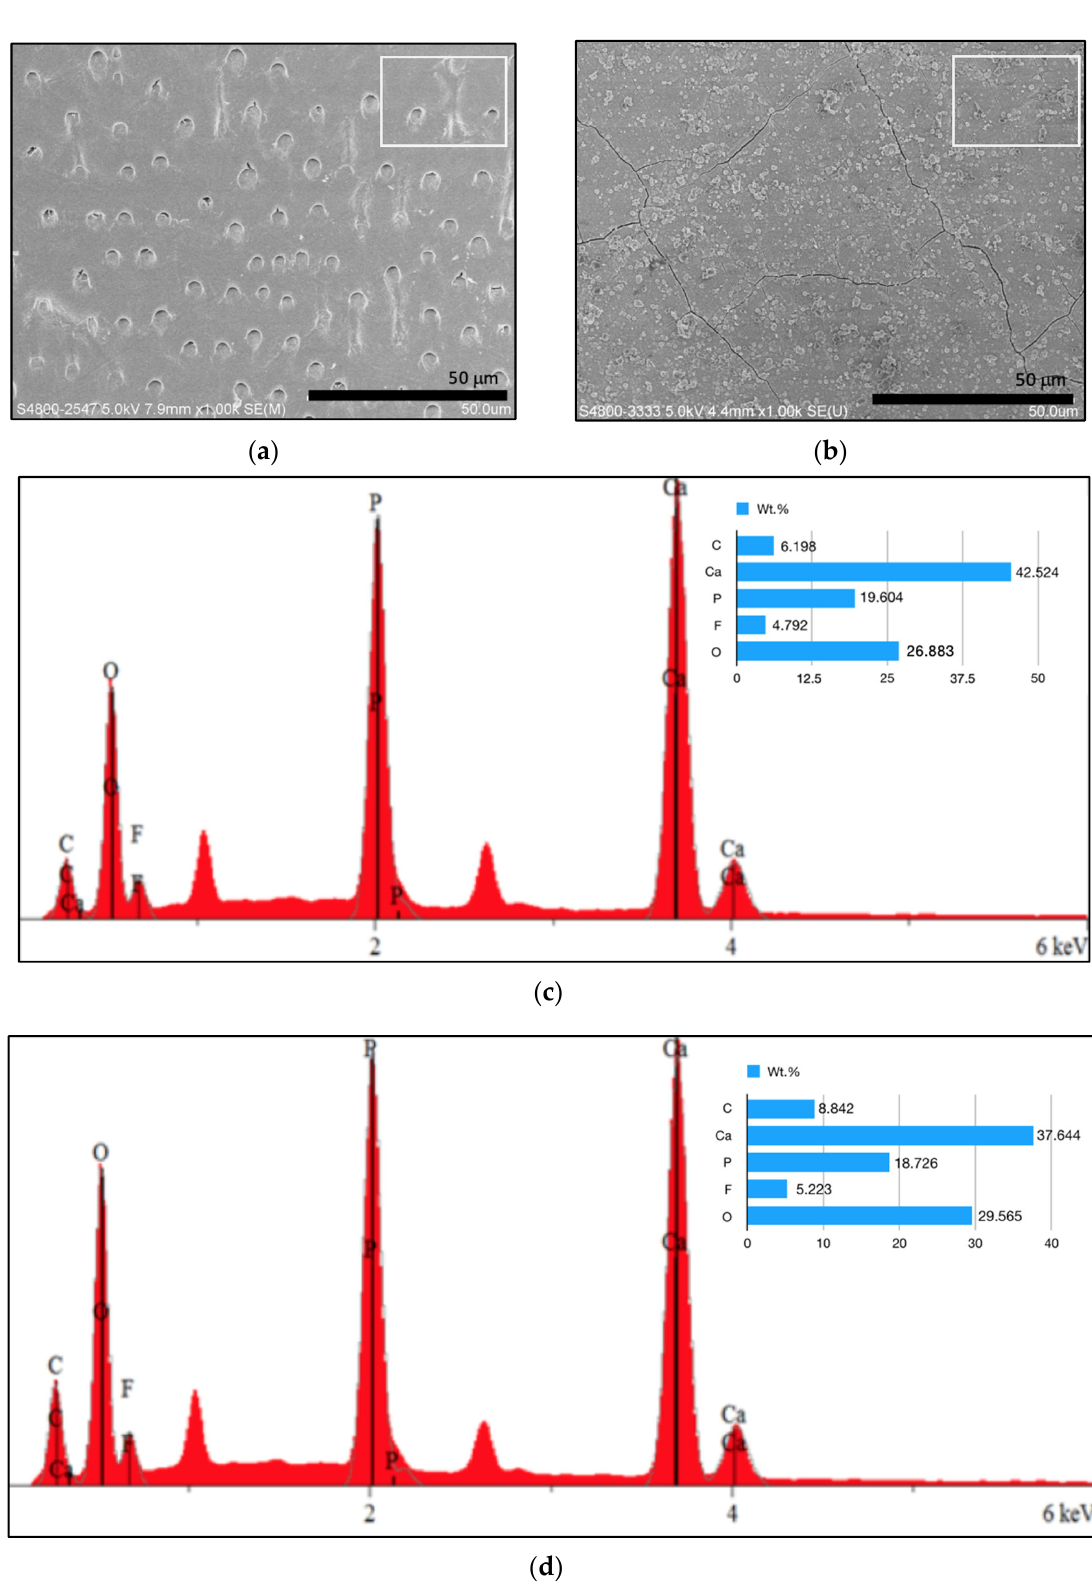
Figure 3. SEM micrograph of remineralized dentin slices; ( a ) dentin surface after remineralization without the aid of electrophoresis-aided system; ( b ) dentin surface after remineralization treated with electrophoresis-aided system and addition of GO; ( c ) energy dispersive spectroscopy (EDS) of remineralized area (rectangle) in ( a ); ( d ) EDS of remineralized area (rectangle) in ( b ). Table 1. Average concentration (wt.%) of control group (without the aid of electrophoresis) and experimental group (with the aid of electrophoresis) with addition of GO.